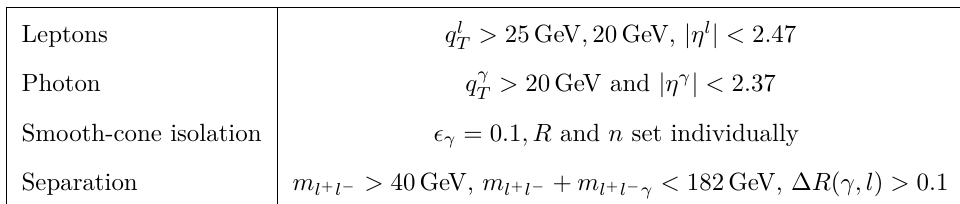
Table 7. Benchmark cuts enhancing the s -channel contribution in Zγ production with Z → e + e − √ decay at a center of mass energy s = 13 TeV